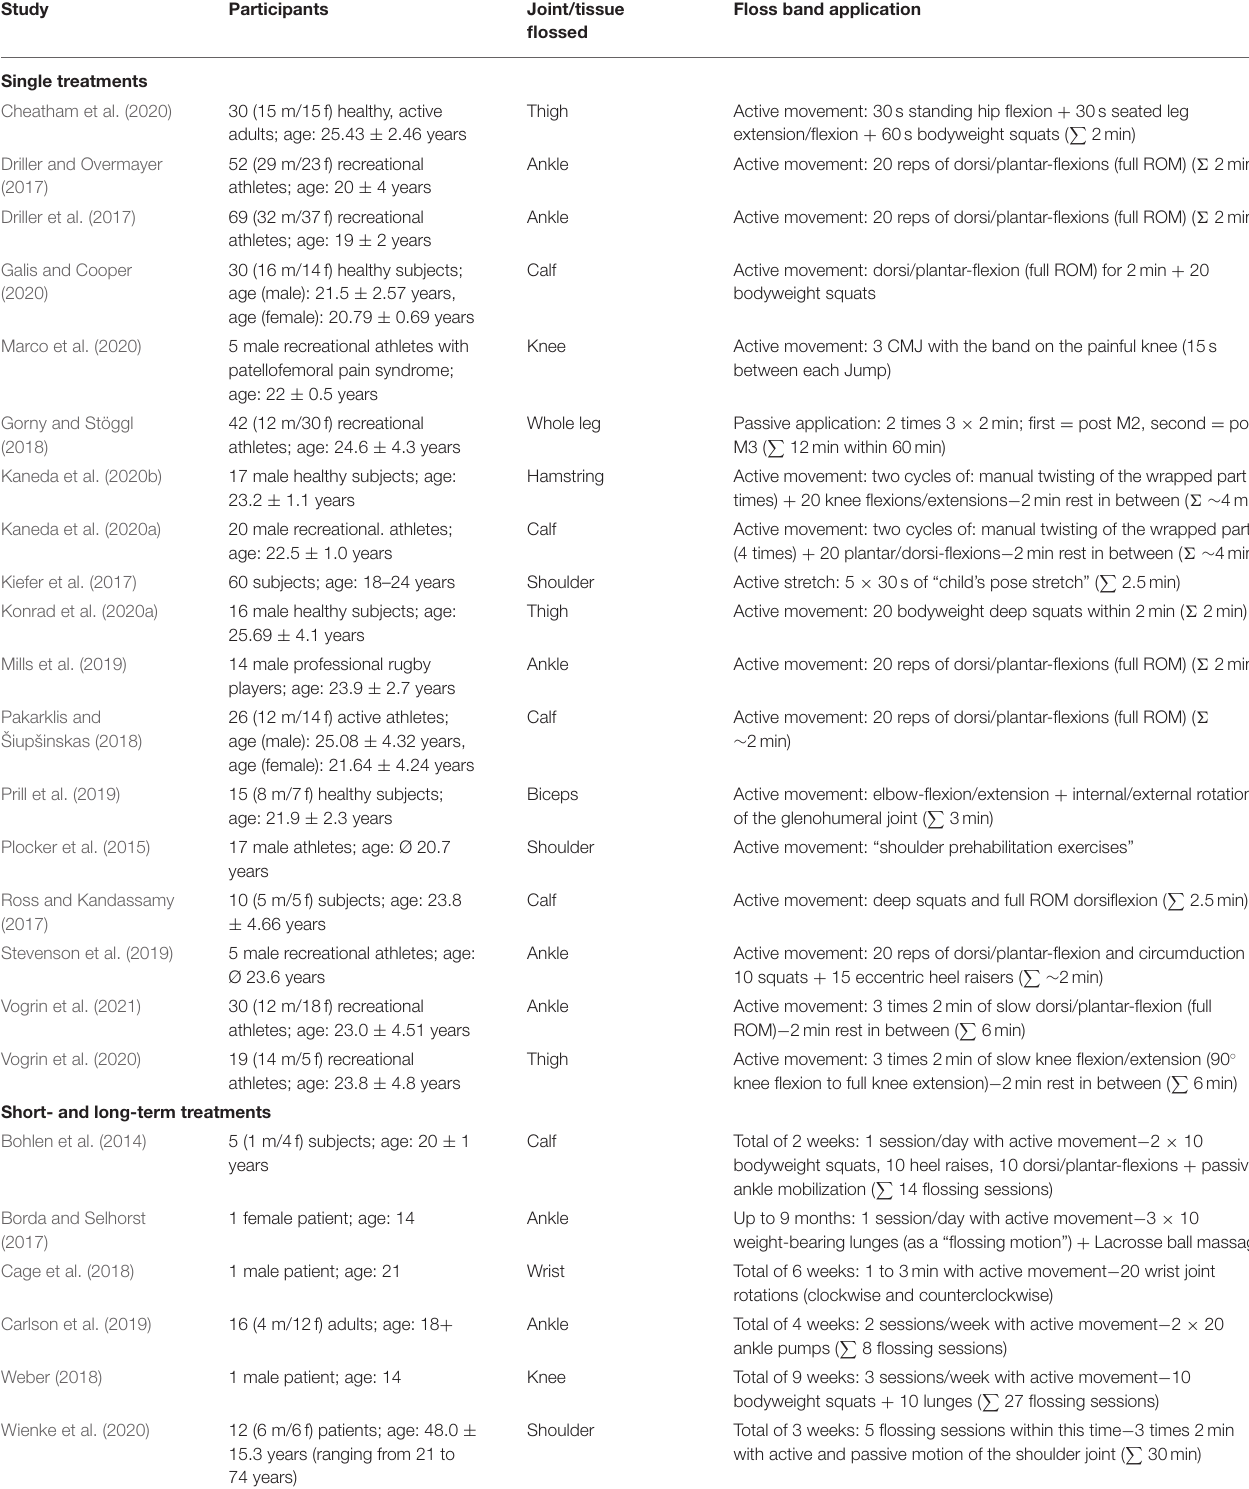
TABLE 1 | Characteristics of the participants of all the included studies ( n = 24) and a description of the floss band application.